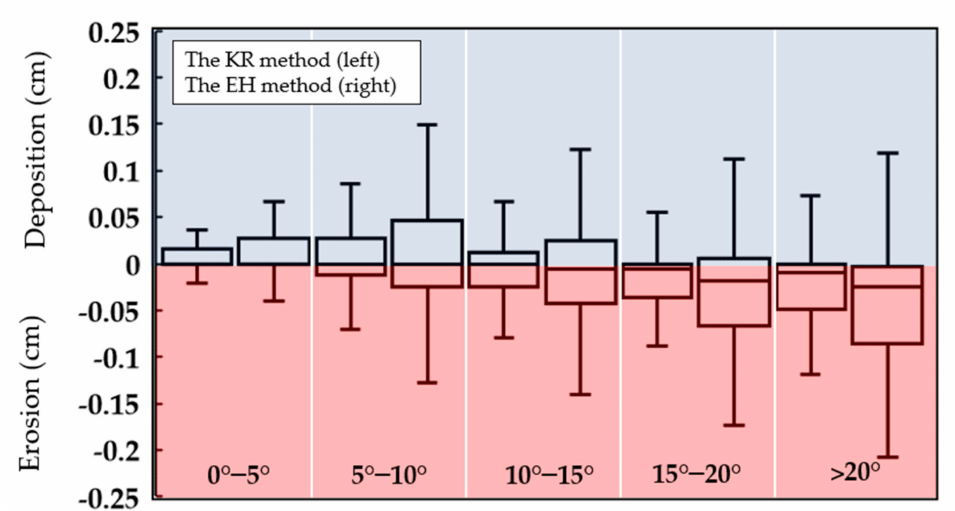
Figure 8. Boxplots of slope gradients show erosion/deposition behavior in three events. In each boxplot, the central line is the median, whereas the edges of the boxes denote the 25th and 75th percentiles, respectively. The upper and lower whiskers denote the maximum and minimum, respectively.